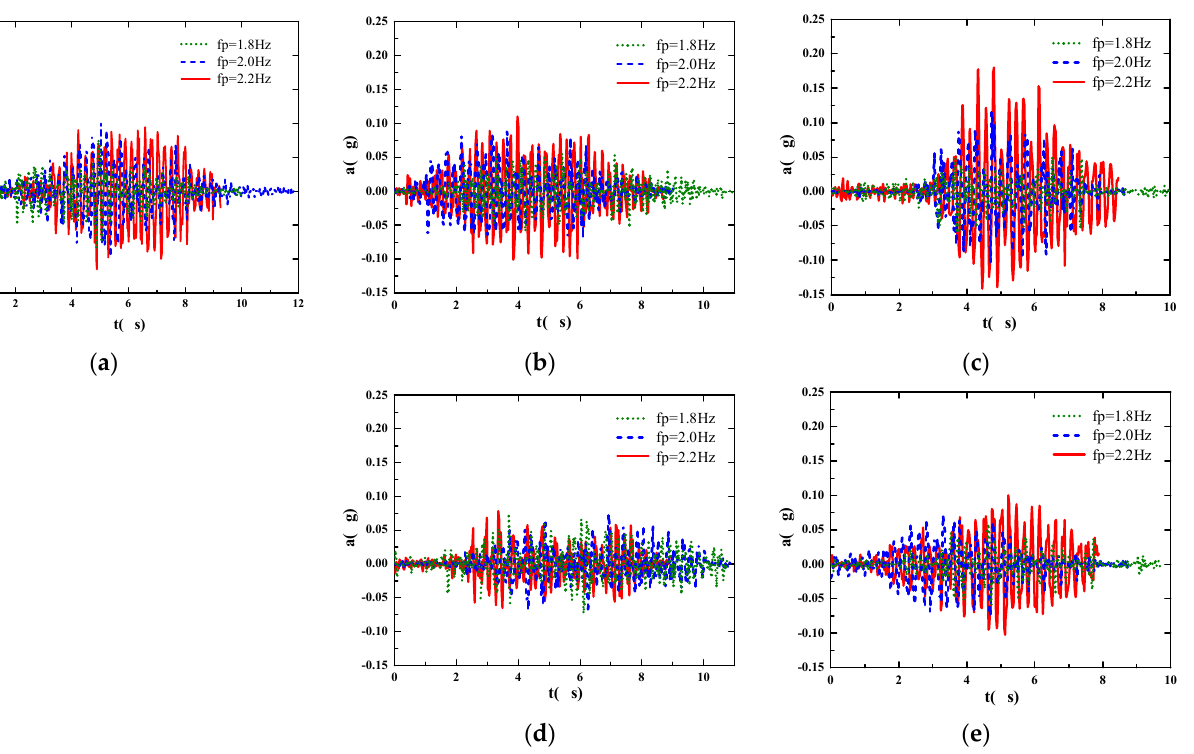
Figure 14. Global acceleration of the footbridge under 15 working conditions. ( a ) Global acceleration